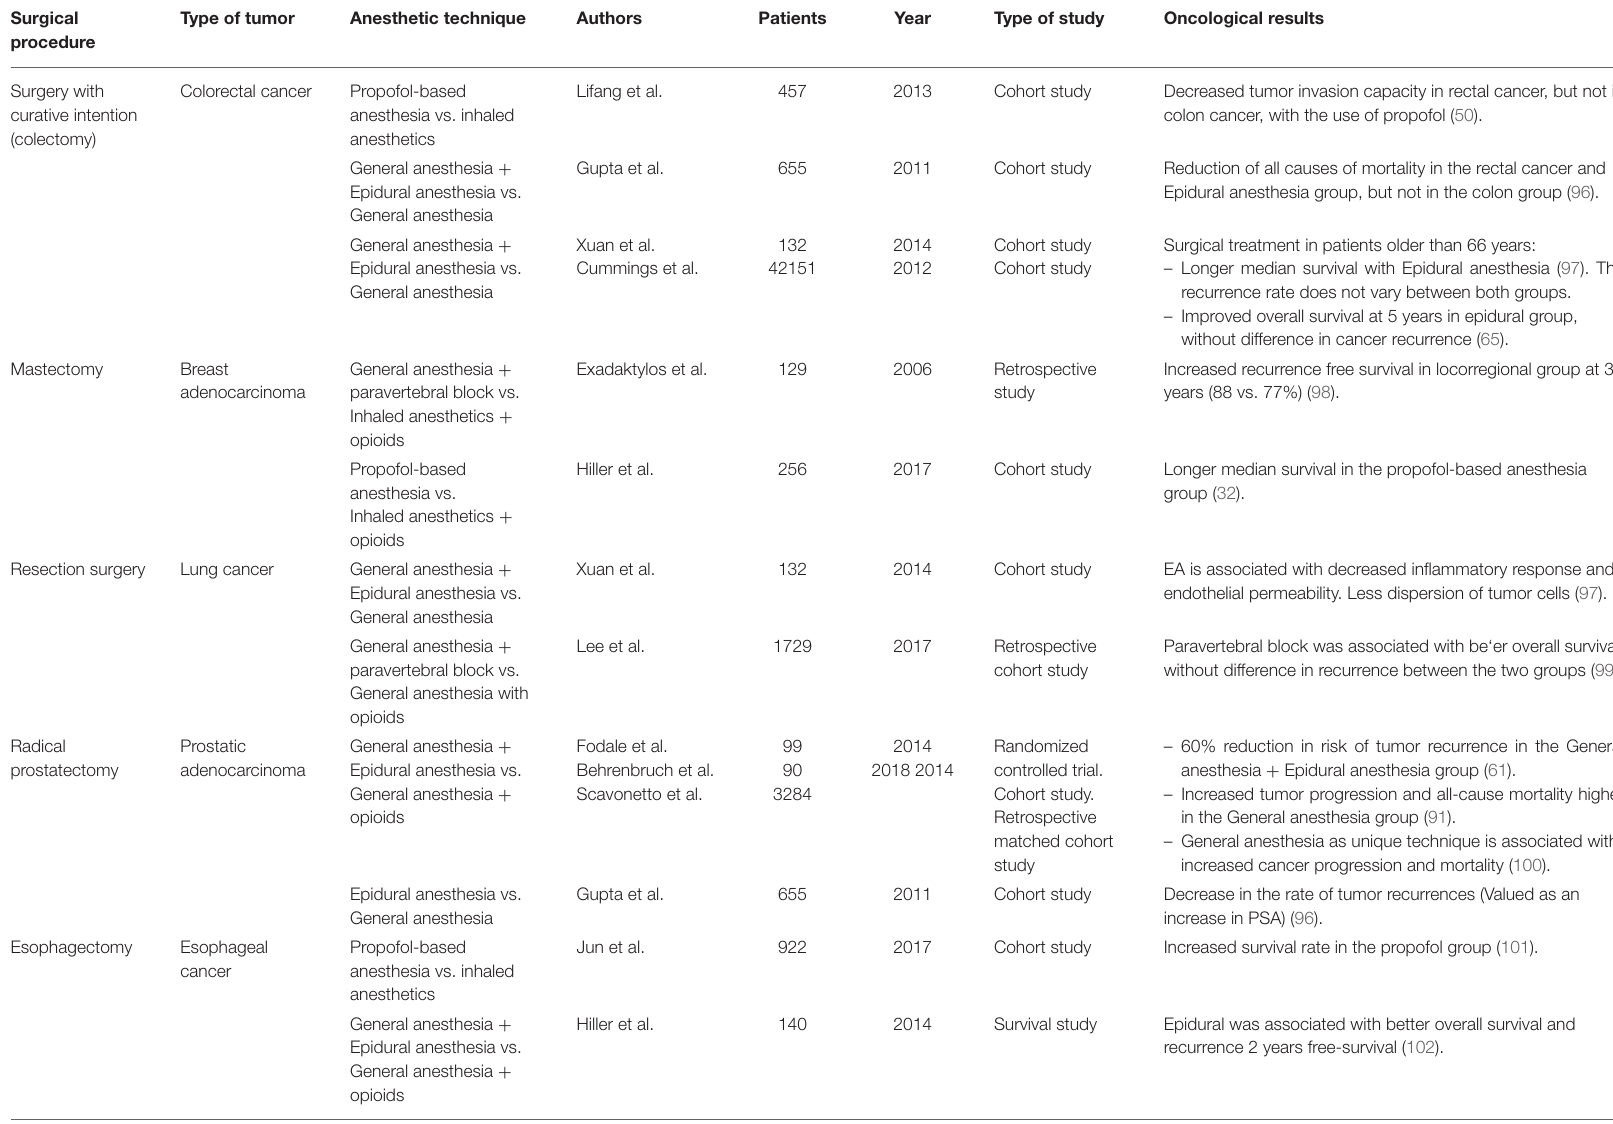
TABLE 2 | Relationship studies between surgical procedure as cancer treatment, anesthetic technique adopted, and